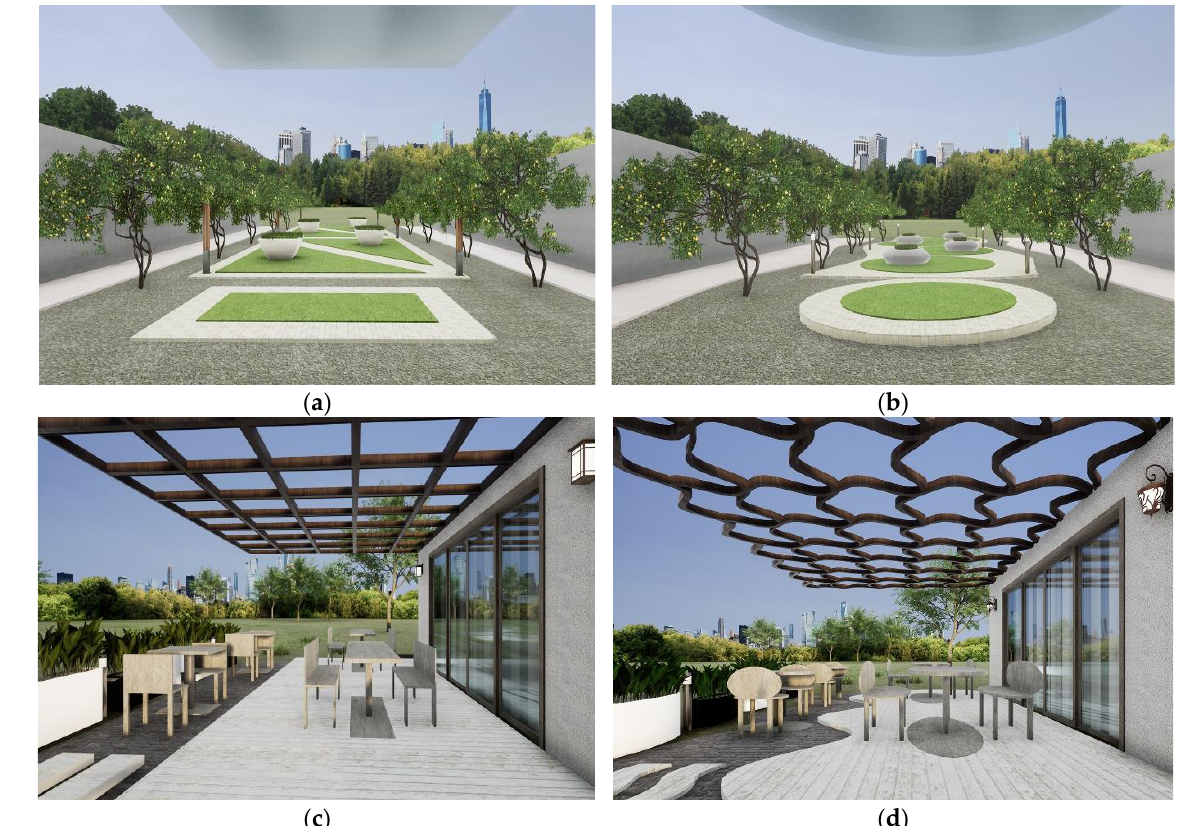
Figure 3. The layout of the four virtual reality transitional spaces. Note: A curved and A linear is café space, B curved and B linear is plaza space. ( a ) A curved environment; ( b ) A linear environment; ( c ) B curved environment; ( d ) B linear environment.